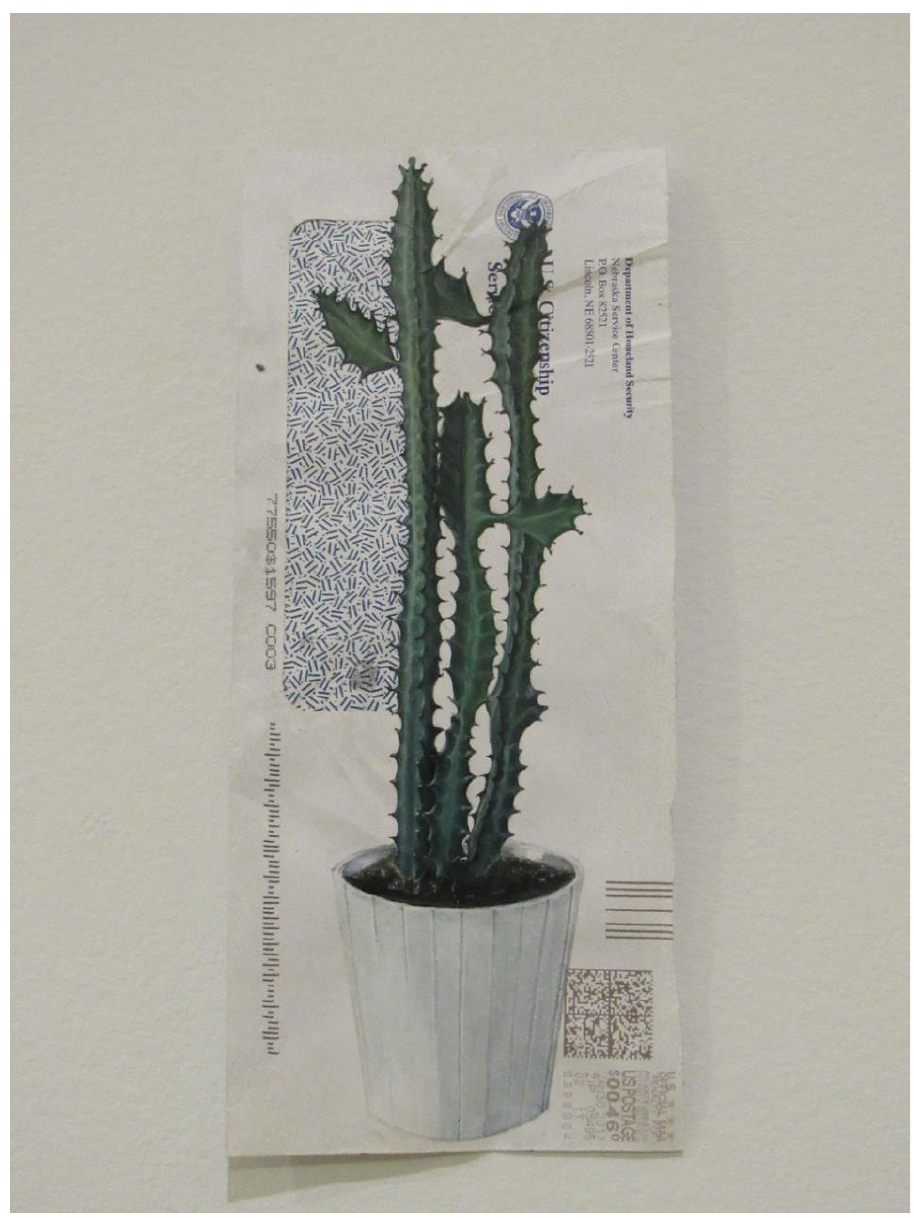
Figure 9 Fidencio Fifield-Pérez, detail from Dacaments 1-17 (2017-2019). Acrylic on paper